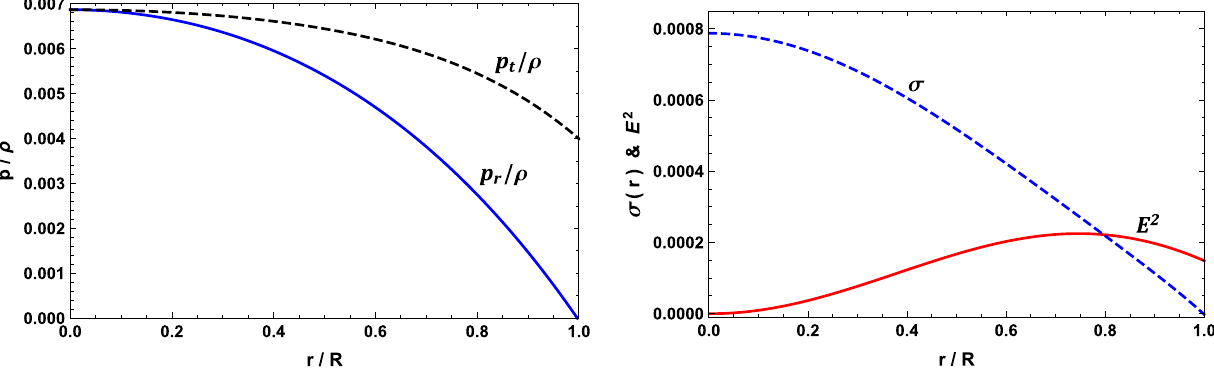
Fig. 3 The p /ρ and electric field intensity ( E 2 ) with charge density (σ) are plotted against r / R by taking the same values as in Fig. 1 for PSR